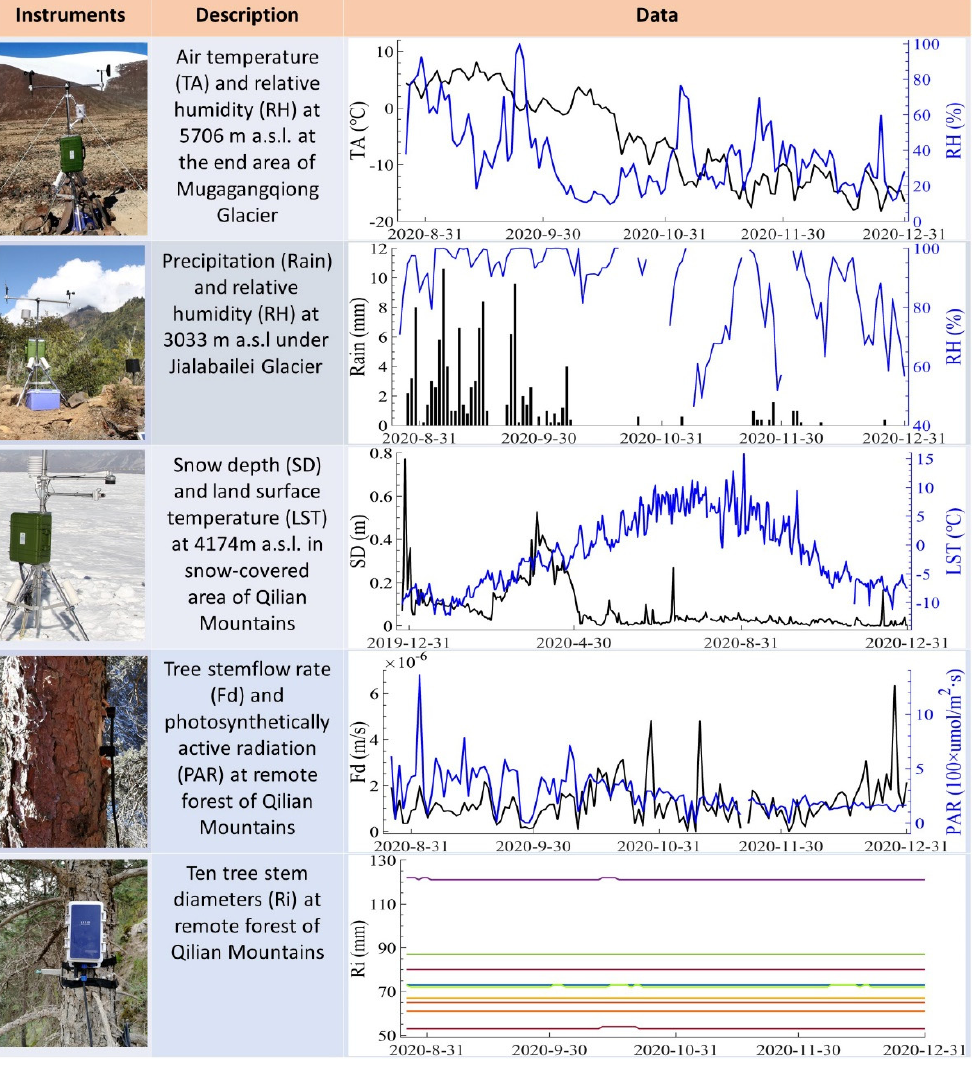
Figure 6. Featured instruments and observation data. The instrument column provides the environ- mental monitoring device deployed in the farmost areas on the TP, the description column briefly introduces the featured variables, and the data column presents the variation in these data retrieved from the surrounding area of two glaciers on the TP and remote areas in the Qilian Mountains.